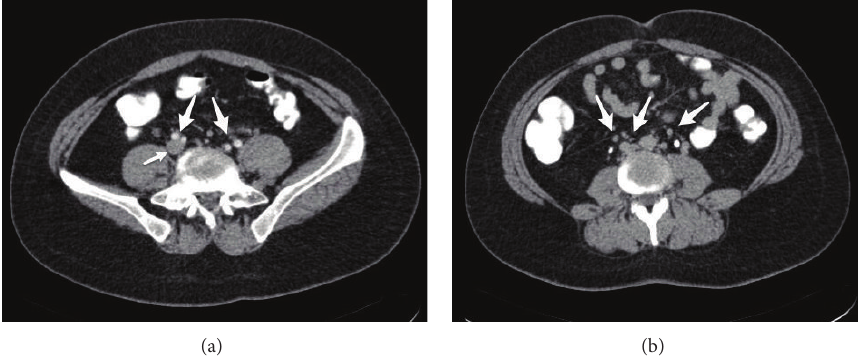
Figure 2: Axial CT image shows the patent left and right internal and external iliac arteries (arrows) and the patent right common iliac vein (small arrow) (a). Axial CT image from a lower level shows the collateral vascular structures (arrows)